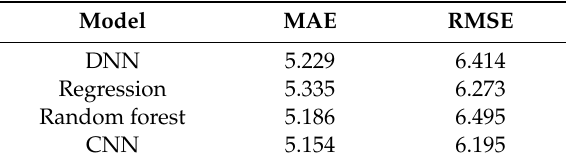
Table 3. The results for the four models using the segmentation method.